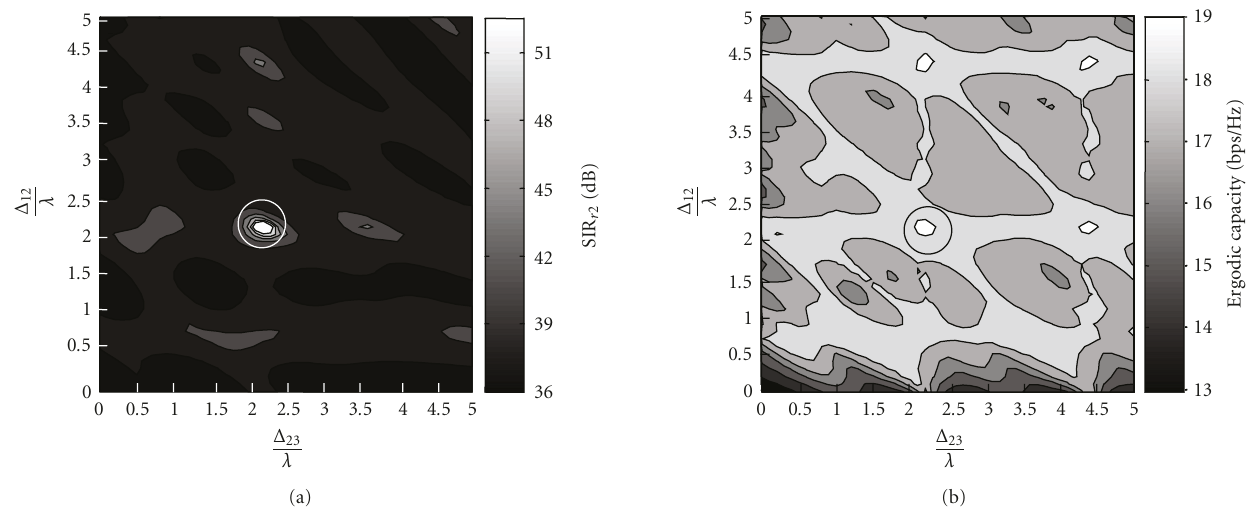
Figure 6: Setting B: rank-2 approximation of the signal-to-interference ratio, SIR r 2 ( Δ , η ), (23) versus Δ 12 /λ and Δ 23 /λ (a) compared with ergodic capacity C ( Δ , η ) (b) ( r = 50 m). Circles denote optimal solutions. (cid:10)(cid:10) where S ( x , θ n , θ m ) = cos[2 πx (sin( θ n ) − sin( θ m ))], L =